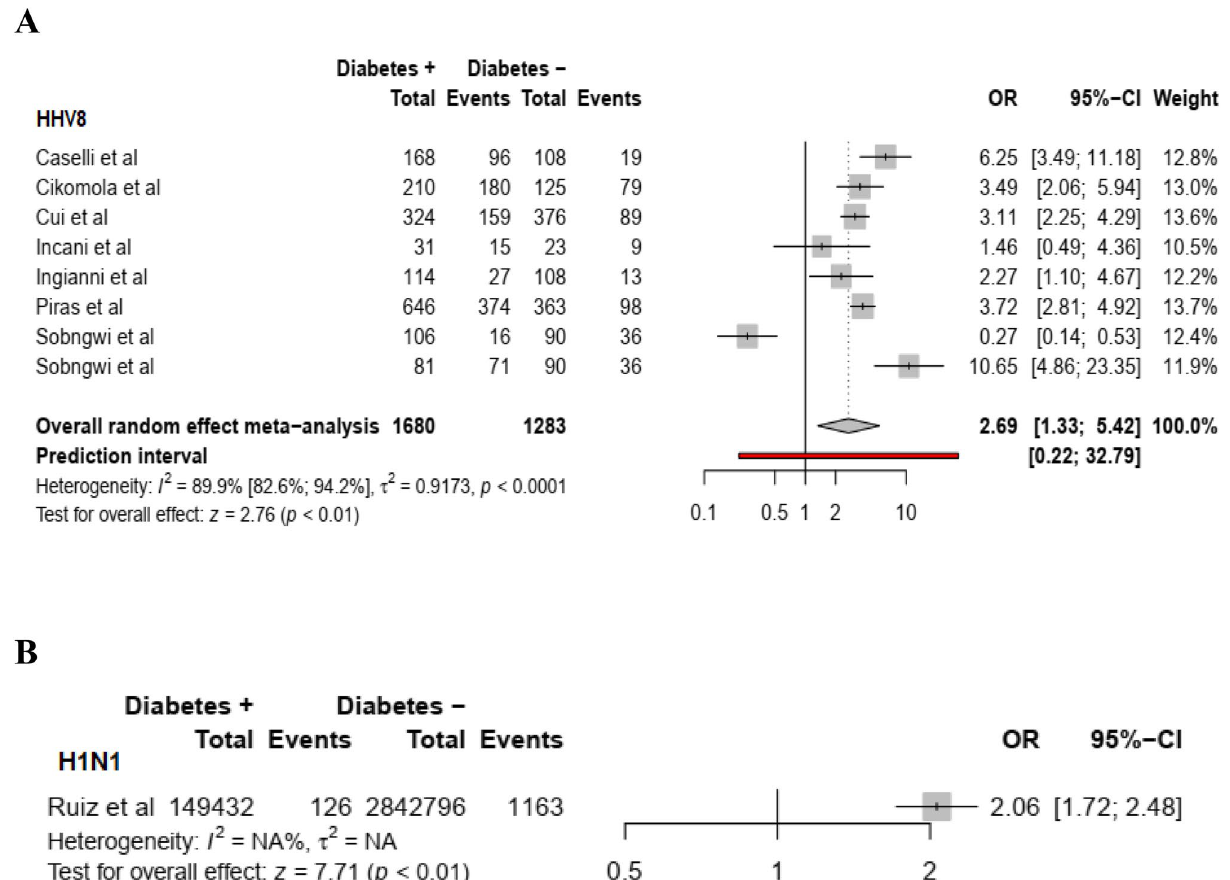
Figure 2. Meta-analysis of the association between HHV8 ( A ), H1N1 virus ( B ) and non-autoimmune diabetes